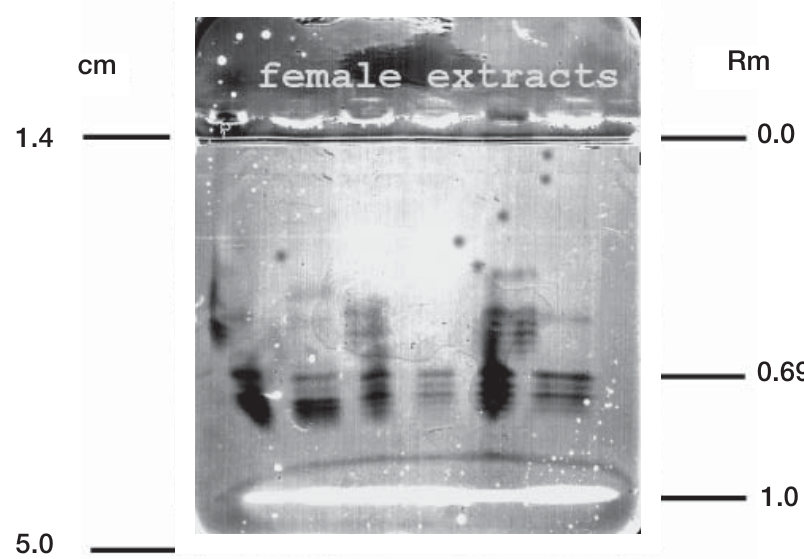
Fig. 1. Native-Page gel of Meloidogyne female extracts stained for SOD activity. The polyacrylamide gradient (8– 25%) pre-cast mini-gel shows a 3.6-cm-long separation zone; 3.8 µl samples were loaded. Bands were tentatively divided into fast-migrating (Rm ≥ 0.69) and slow-migrating (Rm<0.69). After SOD staining the mini-gel was dried and directly scanned into a digital image. This image was turned into a negative in order to show black SOD bands over a gray